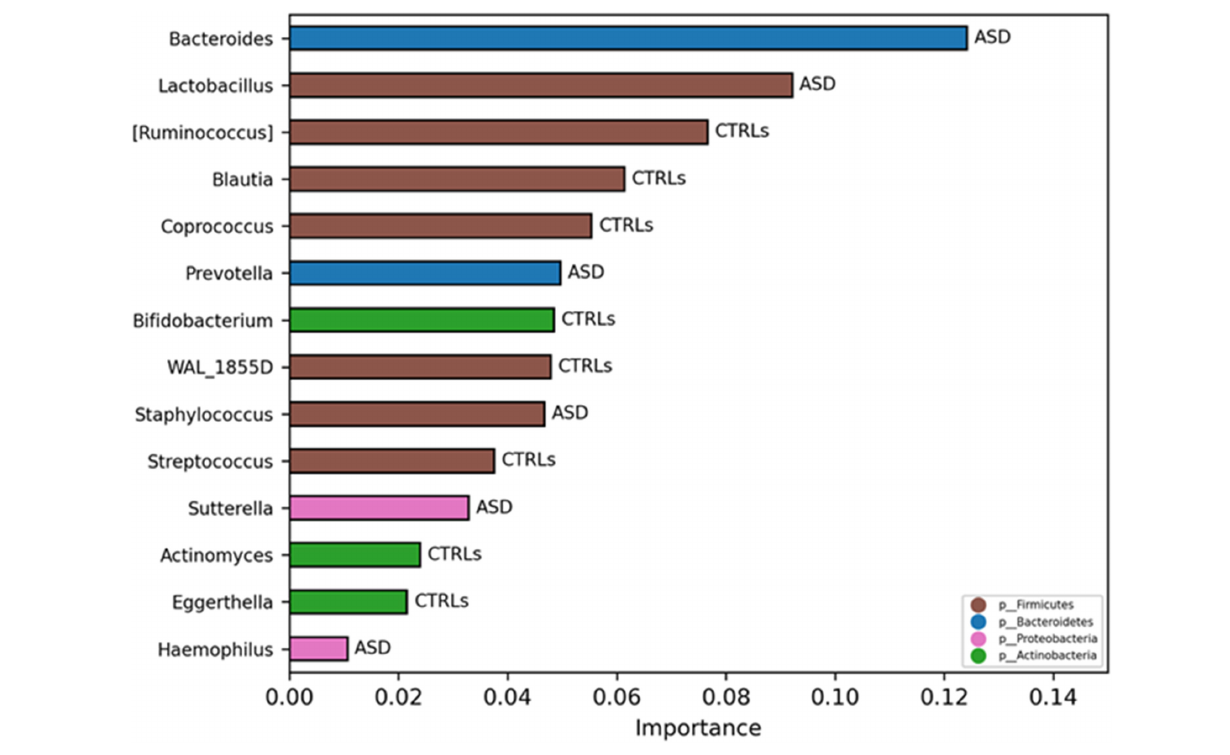
FIGURE 10 | Significant OTUs selected by classification model analysis. The bars represent the importance scores of each OTU in the ASD prediction models versus